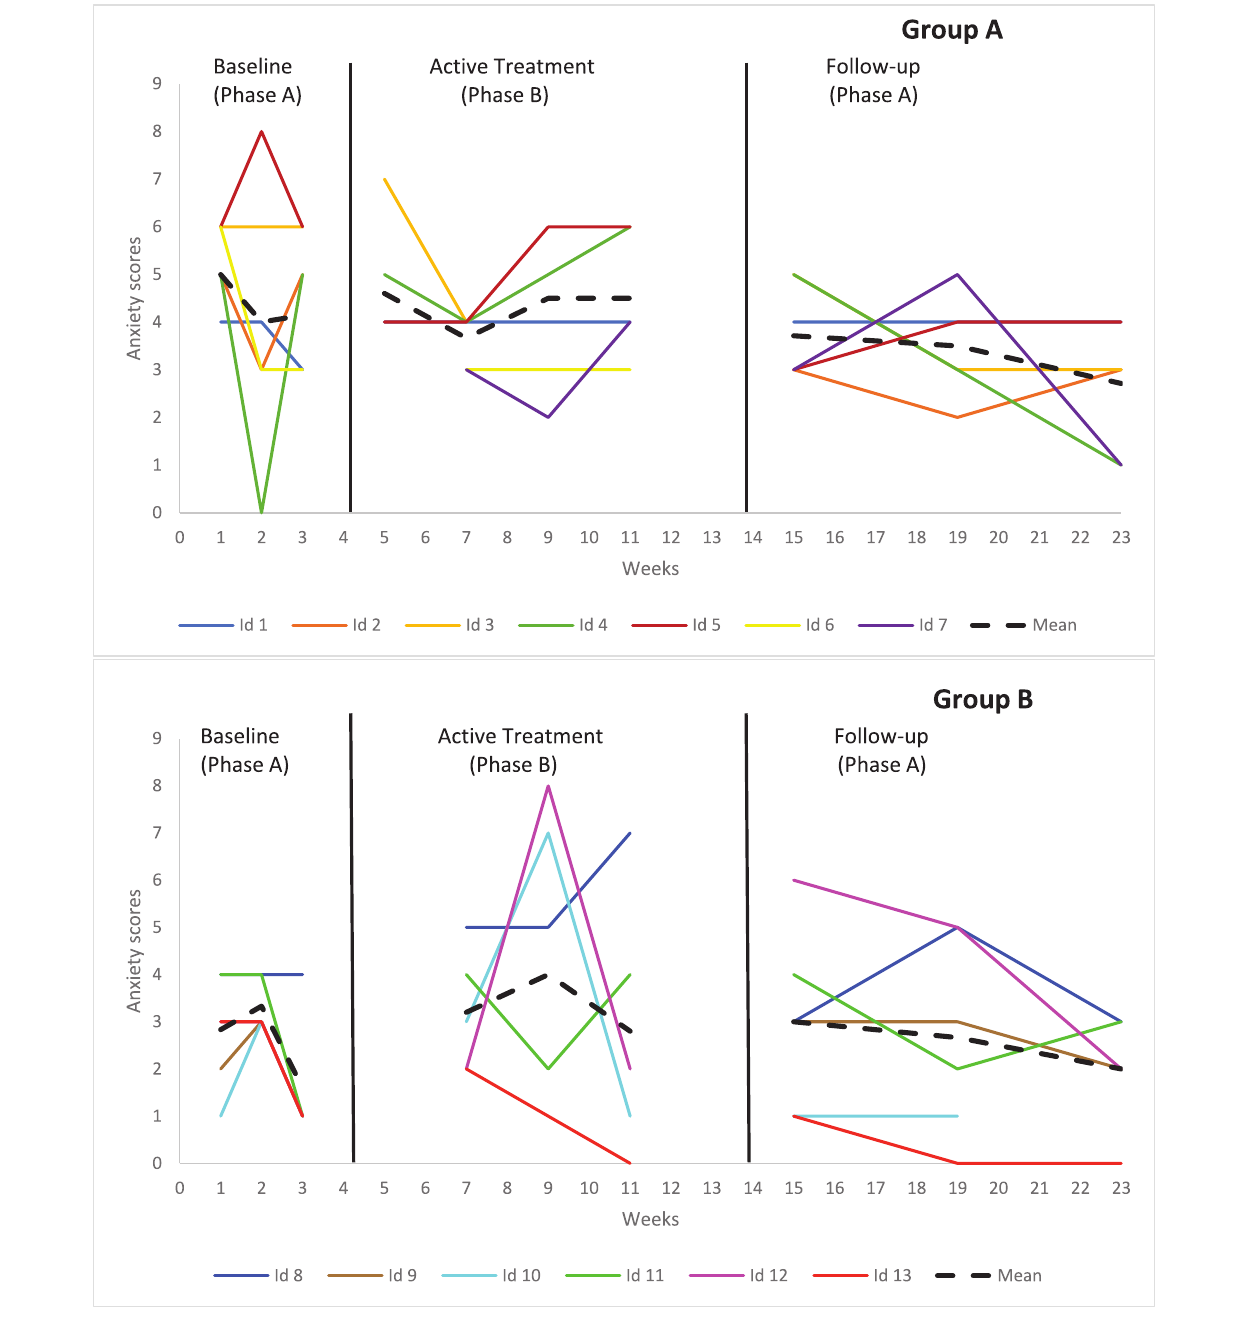
FIGURE 1 | Graphical display of baseline level and changes in level between consecutive phases in anxiety for self-reported data.